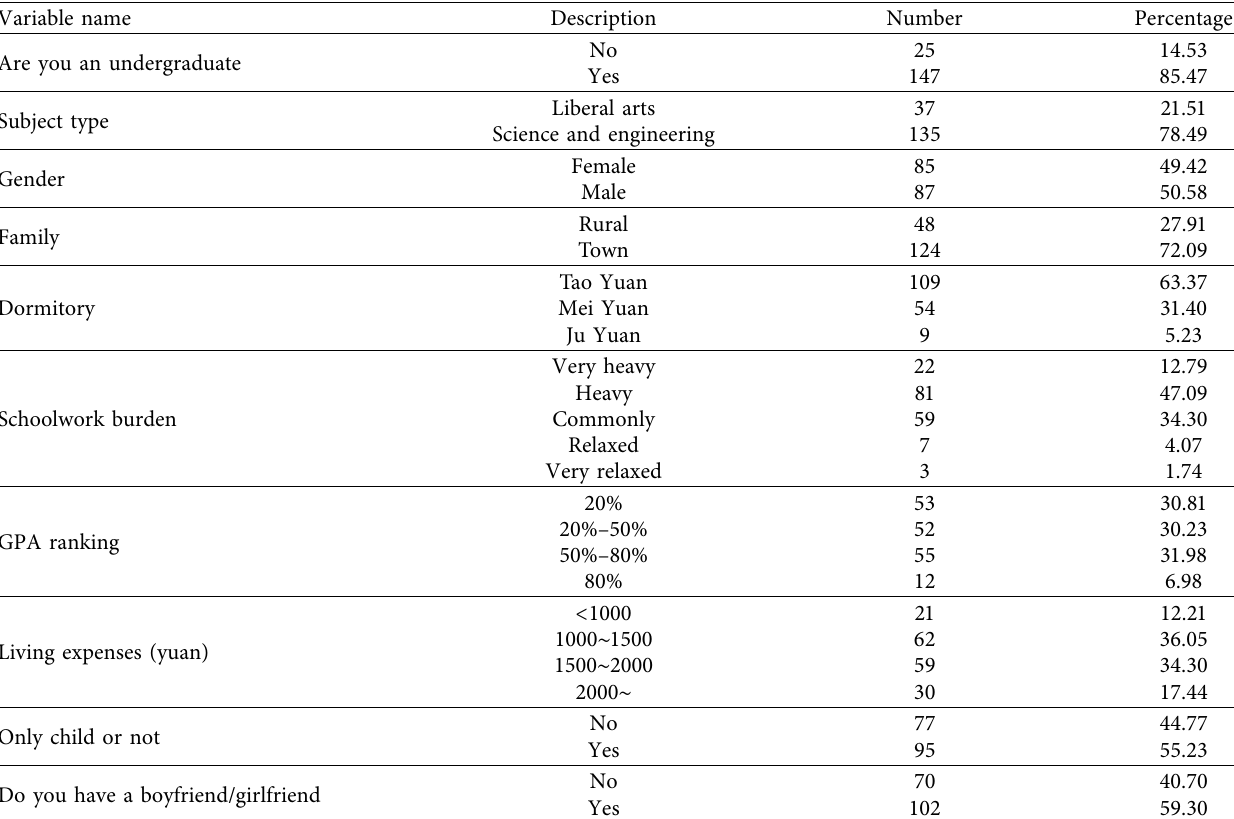
Table 2: Descriptive statistics of social attributes.